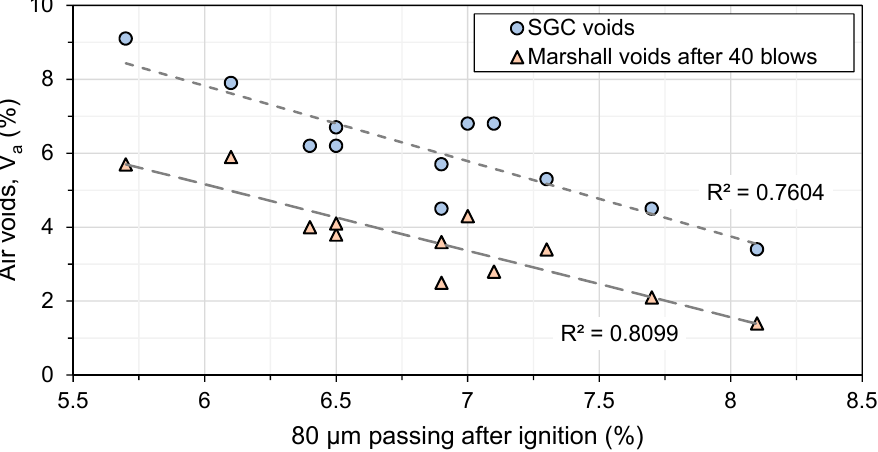
Figure 9. Shear gyratory compactor SGC voids ( n = 1) and Marshall voids after 40 blows ( n = 6) in the function of 80µm sieve-passing after mixing and an ignition test.